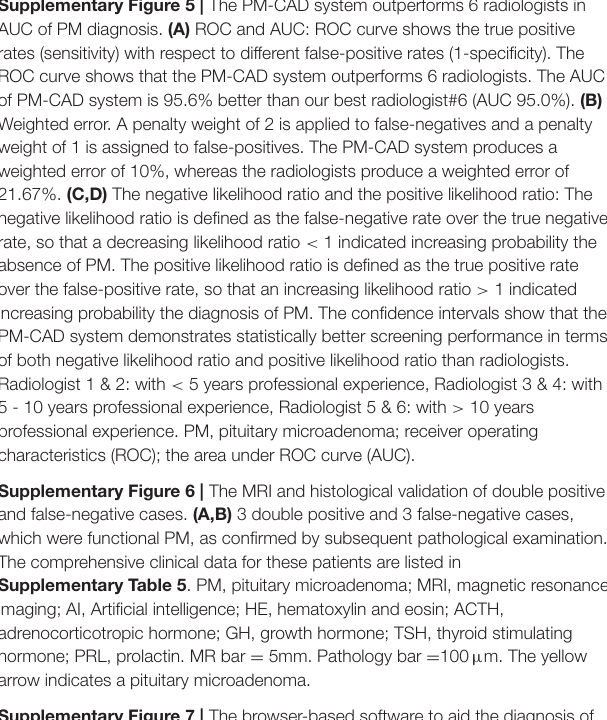
examination of the inferior petrosal sinus in the region of right pituitary gland. On the 4th MRI scanning, two microadenoma are detected by radiologist. (B)